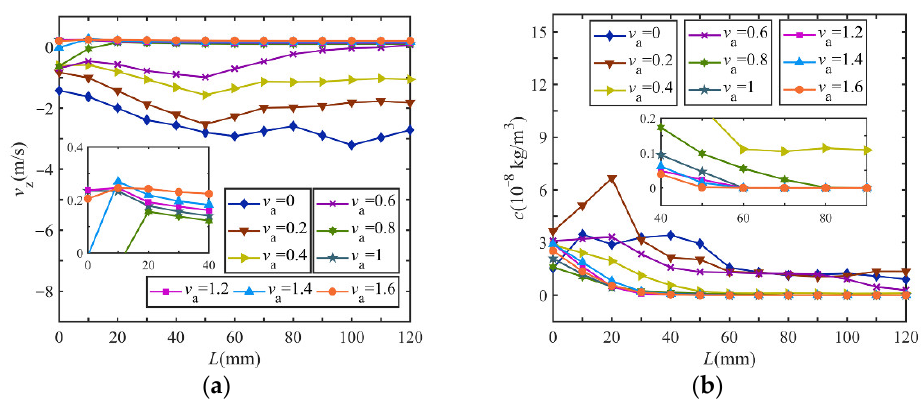
Figure 5. Variation curves of the large-aperture channel sealing indicators for three blowing schemes. ( a ) The v z variation curves with L for different v a ; ( b ) the c variation curves with L for different v a .